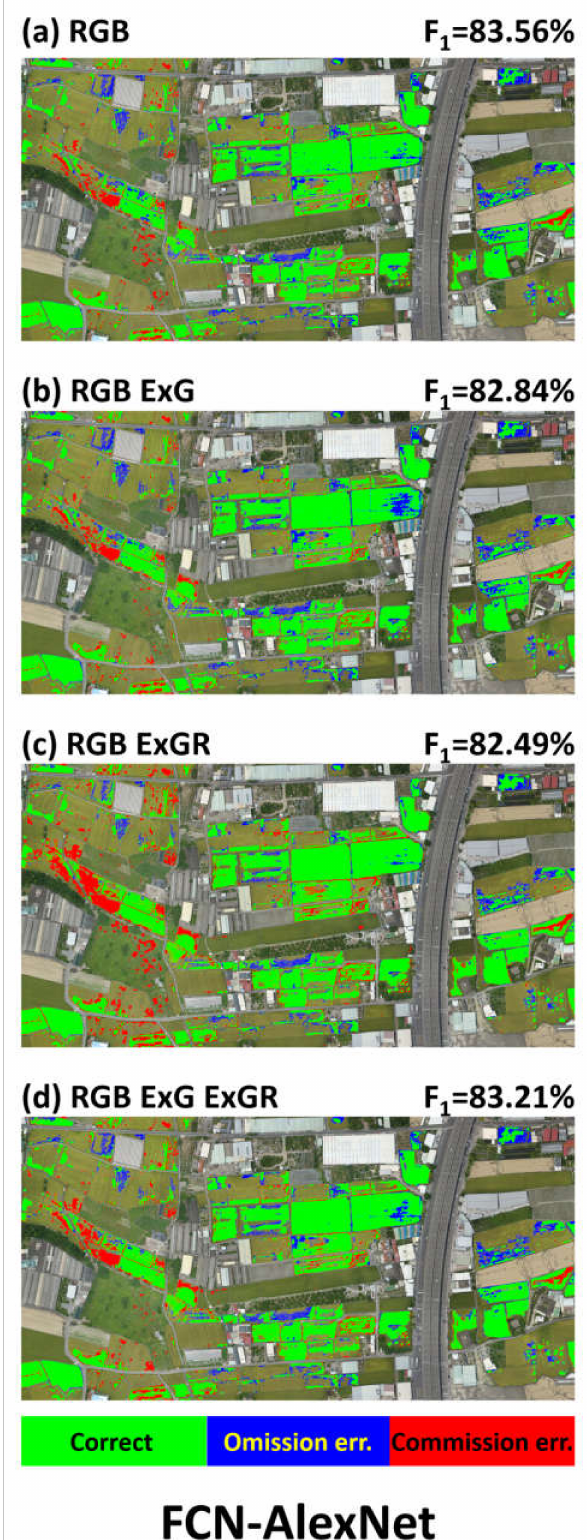
Figure 12. Results of FCN-AlexNet identification for rice lodging on 2017 testing dataset using various spectrum information: ( a ) RGB, ( b ) RGB + ExG, ( c ) RGB + ExGR, and ( d ) RGB + ExG +